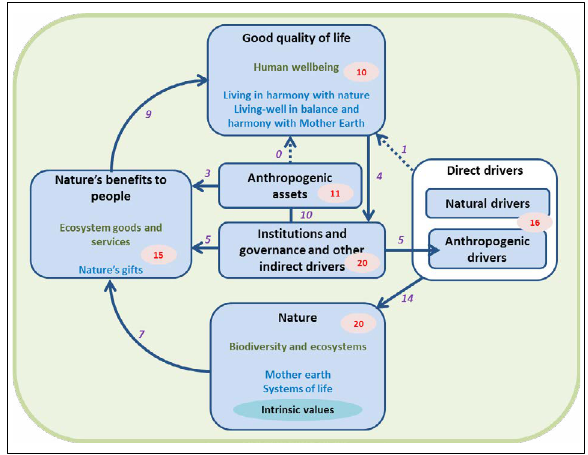
A depiction of how the Cape Floristic Region conservation questions address the core elements and linkages of the Intergovernmental Science-Policy Platform on Biodiversity and Ecosystem Services (IPBES) Conceptual